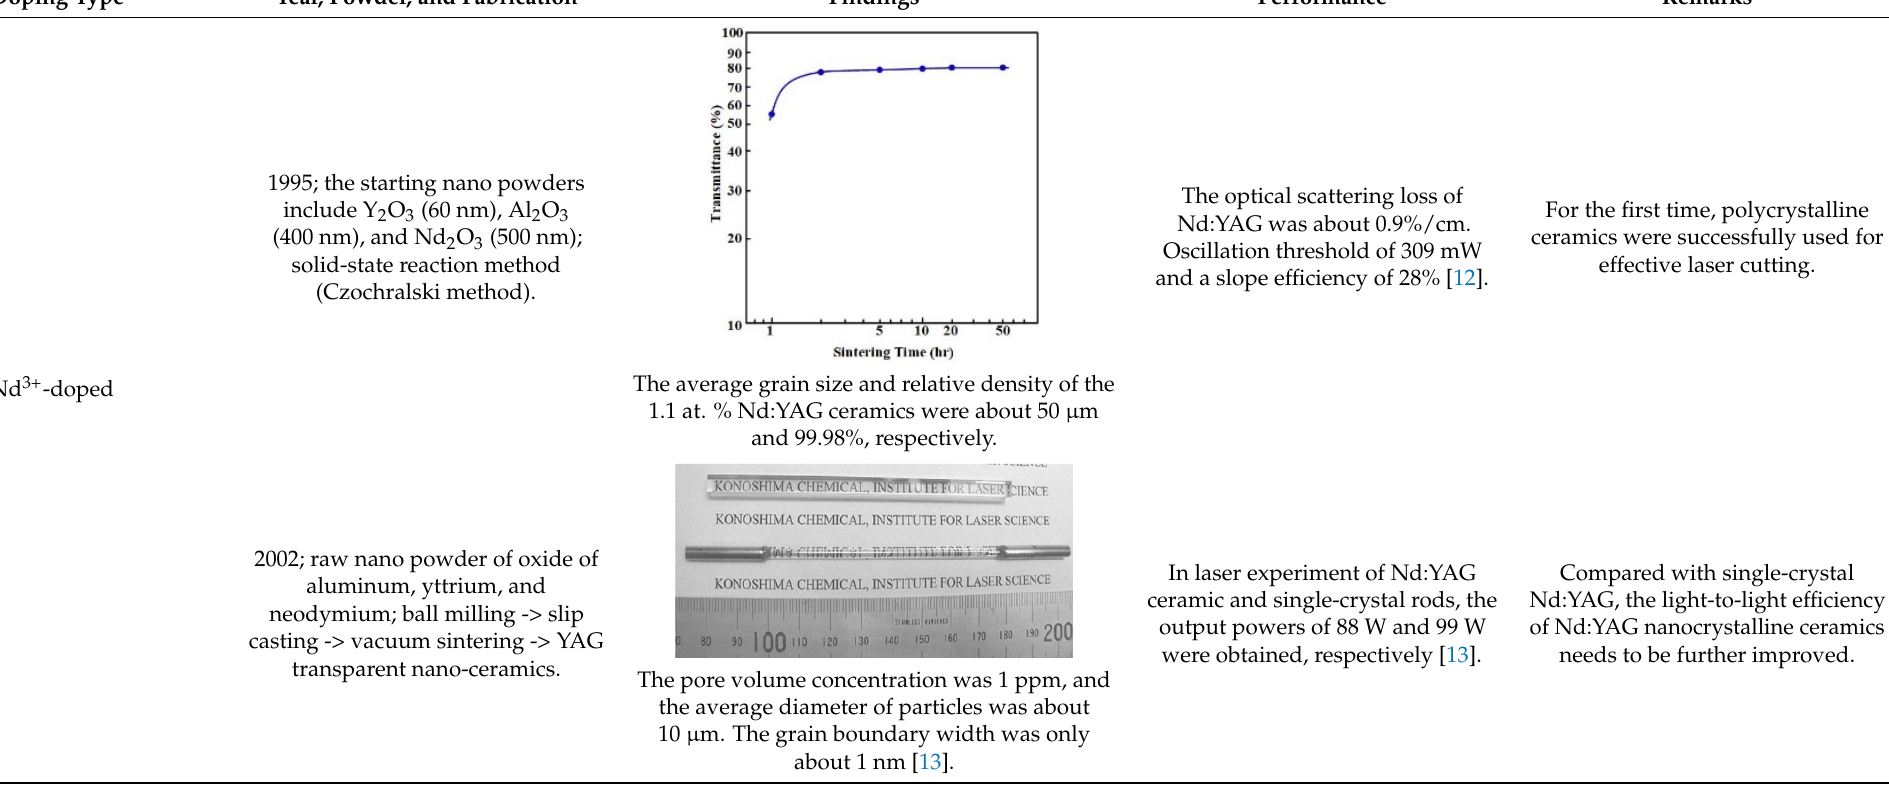
Table 1. Summary of doped YAG transparent nano-ceramics described in the text grouped by doped type and published year.